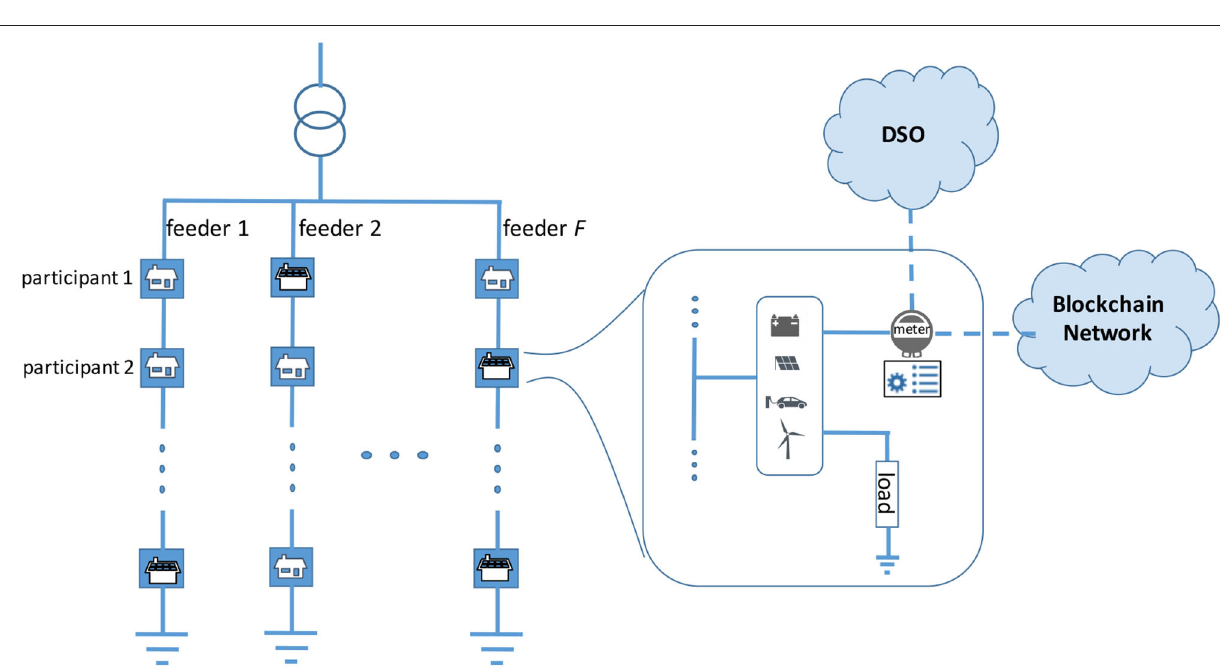
Figure 2 . Each node is associated with a participant in the local peer-to-peer energy trading